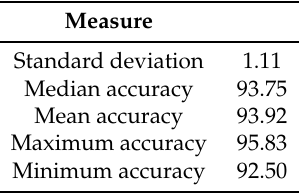
Table 14. SVM3 (GA and database UIBVFED).